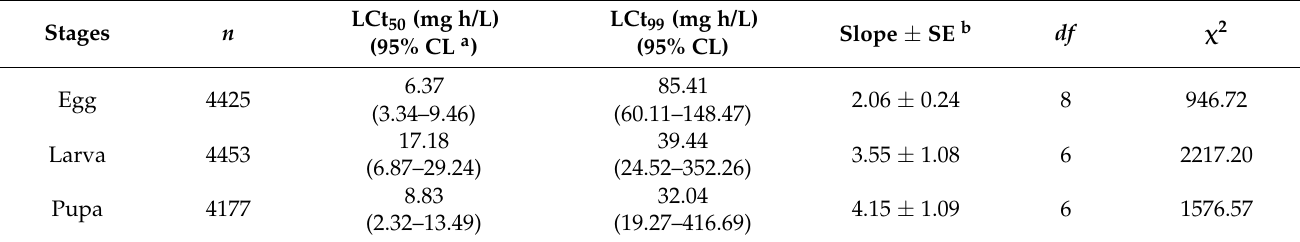
Table 1. Lethal concentration time for D. suzukii exposed to methyl bromide